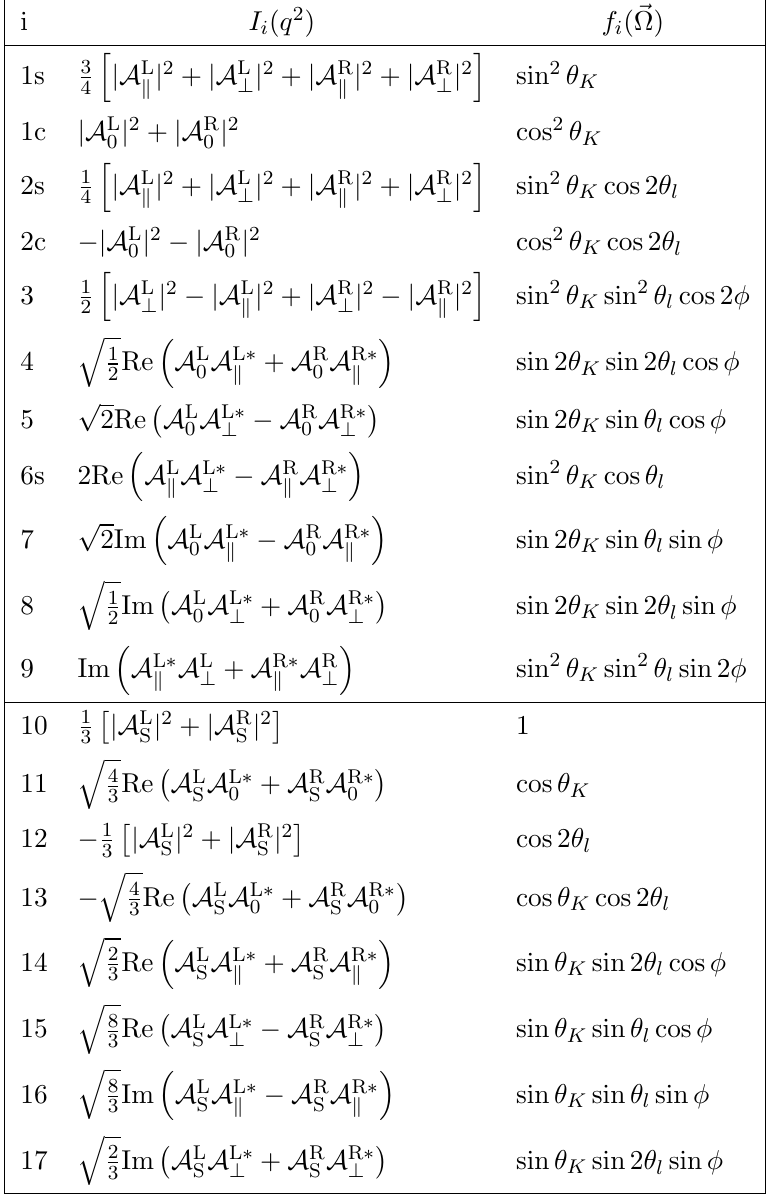
Table 1. Dependence of the angular observables I i ( q 2 ) on the transversity amplitudes A L ; R the corresponding angular terms f i (cos (cid:18) l ; cos (cid:18) K ; (cid:30) ). The angular observables (cid:22) I i ( q 2 ) are given by complex conjugation of all weak phases A ! (cid:22) A .